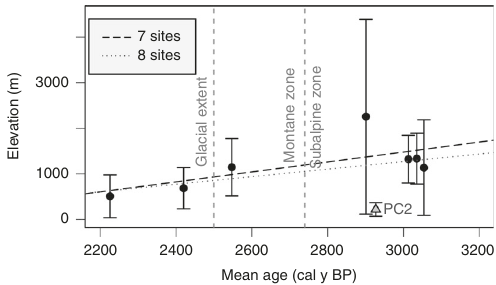
Fig. 3 Site-average 14 C ages with elevation. Error bars indicate the standard deviation for site-average calibrated mean ages, which is denoted by black circles for seven sites and a gray triangle for PC2. Variability explained ( R 2 ) and p values for the regression model of all eight study sites ( R 2 = 0.18, p = 0.29) shows a stronger relationship for the seven study sites excluding site PC2 ( R 2 = 0.43, p = 0.11)